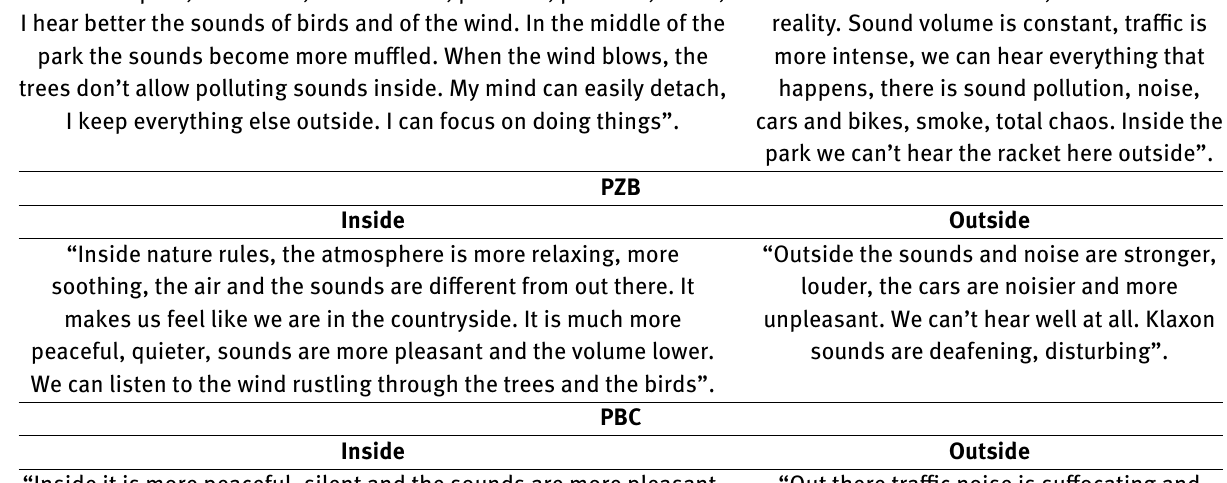
Table 3: Summary of responses on the perception of sound in parks in Belém and Lisbon. Belém BRA Inside